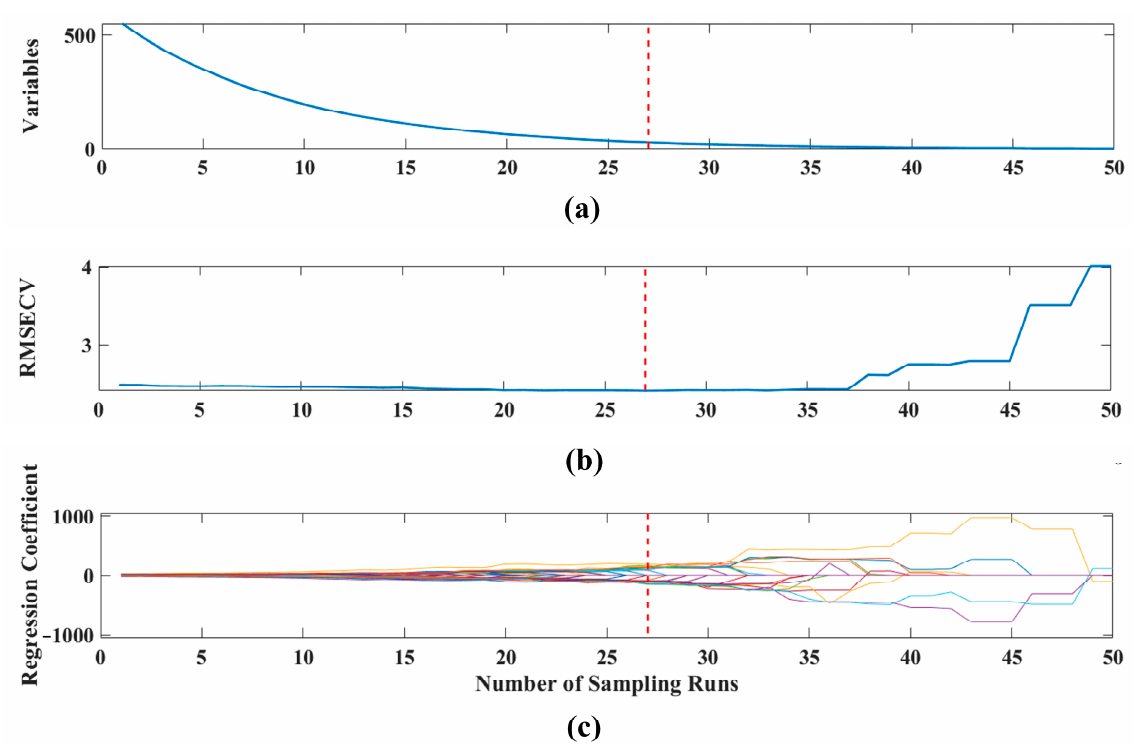
Figure 4. Selection of feature variable based on CARS method, ( a ) number of variables taken for sampling, ( b ) RMSECV values, and ( c ) the path of regression coefficients for each variable as the number of samples increases. The line (labelled with a dashed line) indicates the optimal point with the lowest RMSECV value.